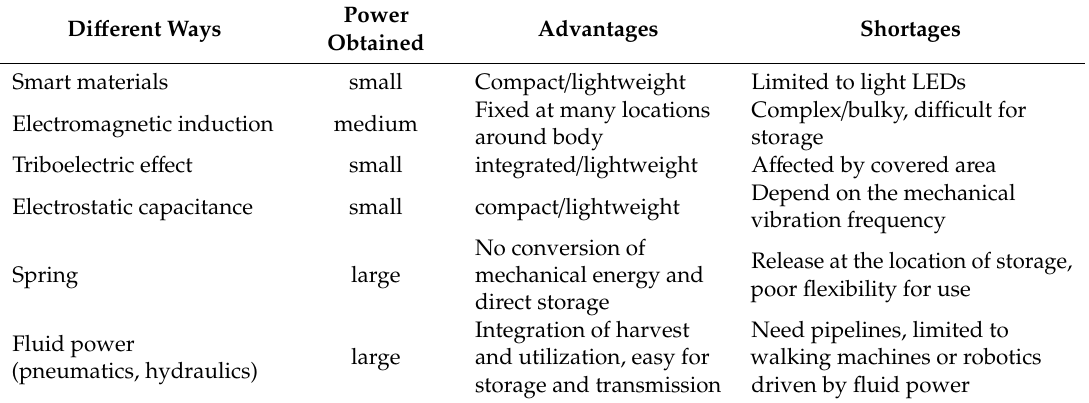
Table 3. Comparison of di ff erent ways of harvesting energy from human